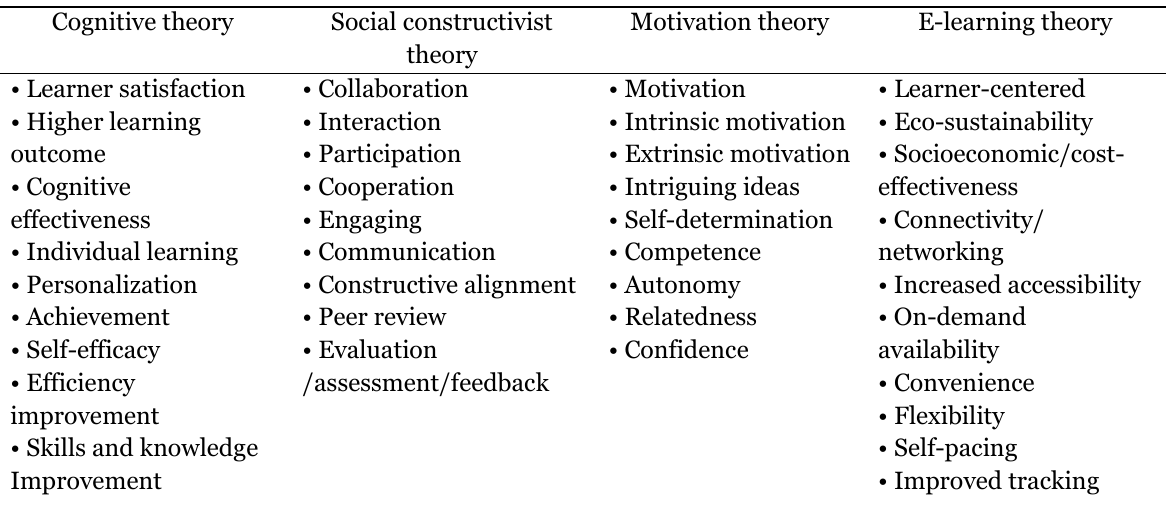
E-Learning Components Categorized by Learning